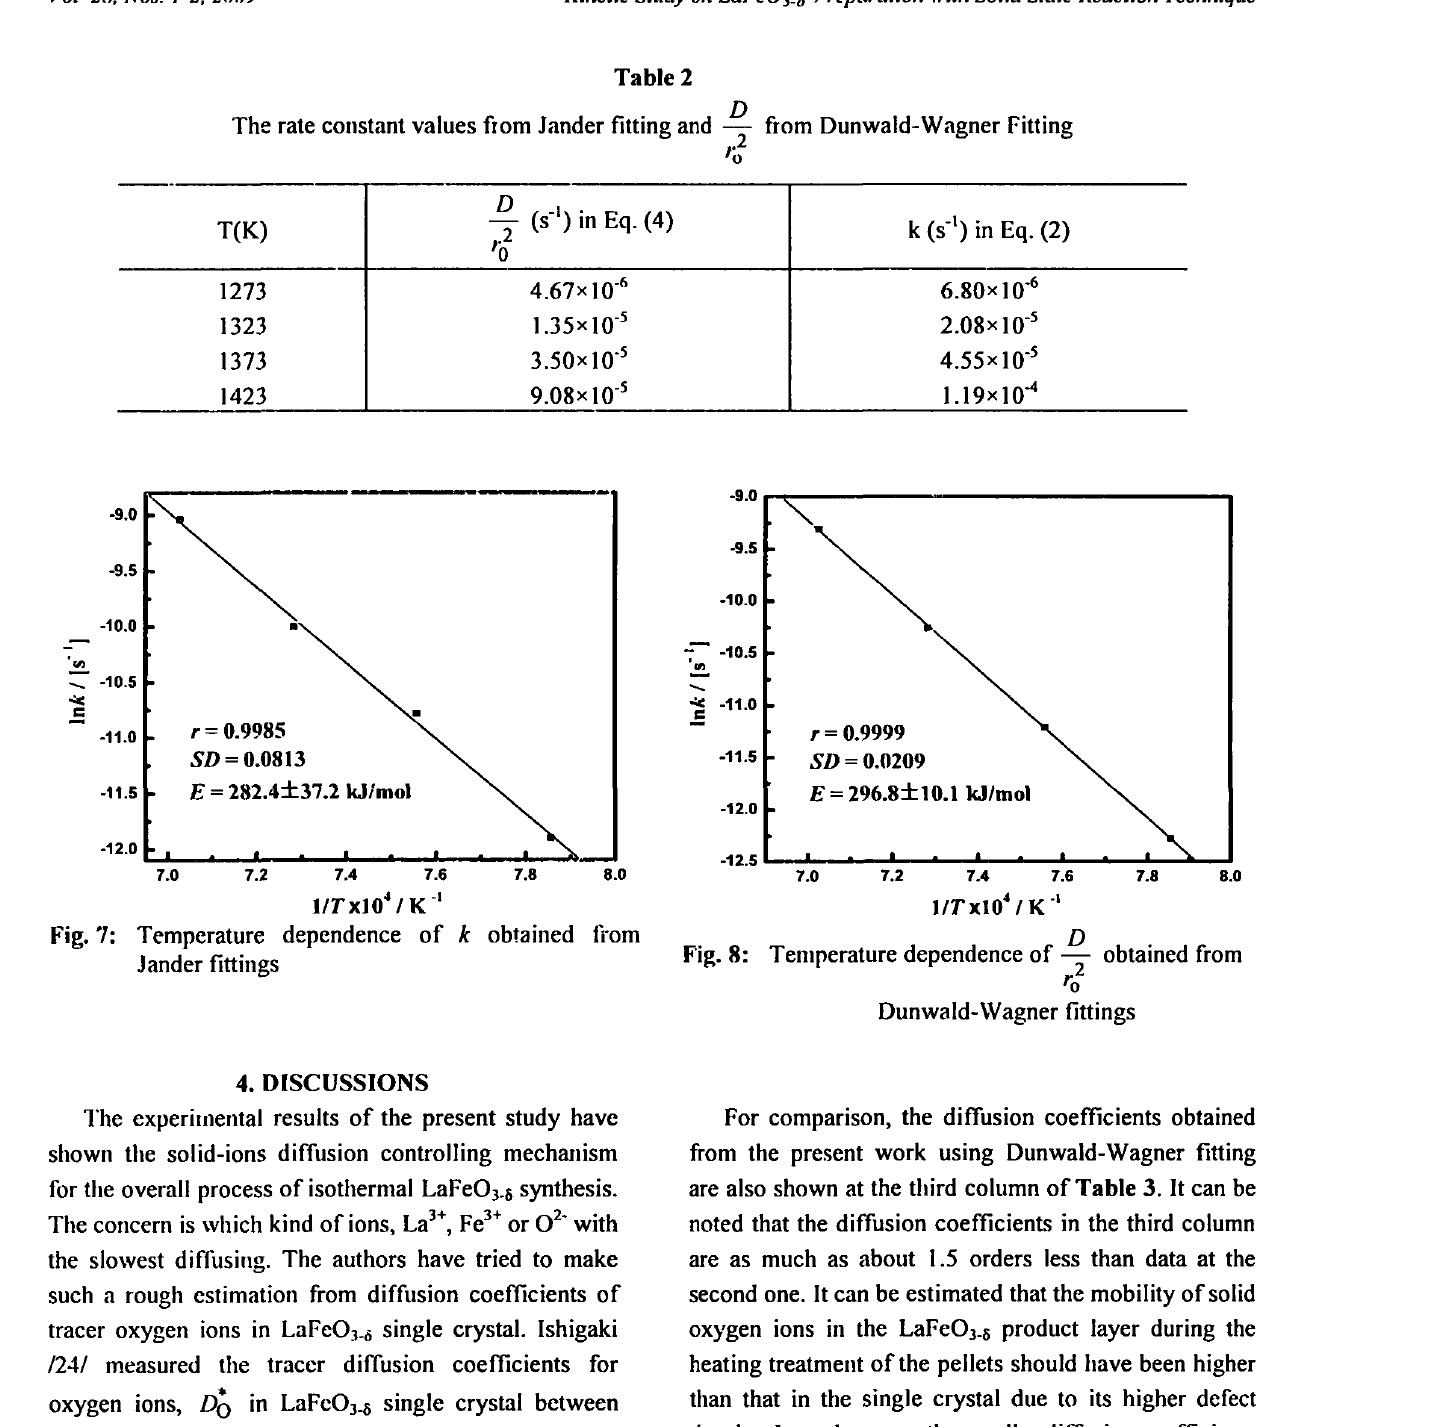
Fig. 7: Temperature dependence of k obtained from Jander fittings Fig. 8: Temperature dependence of — obtained from